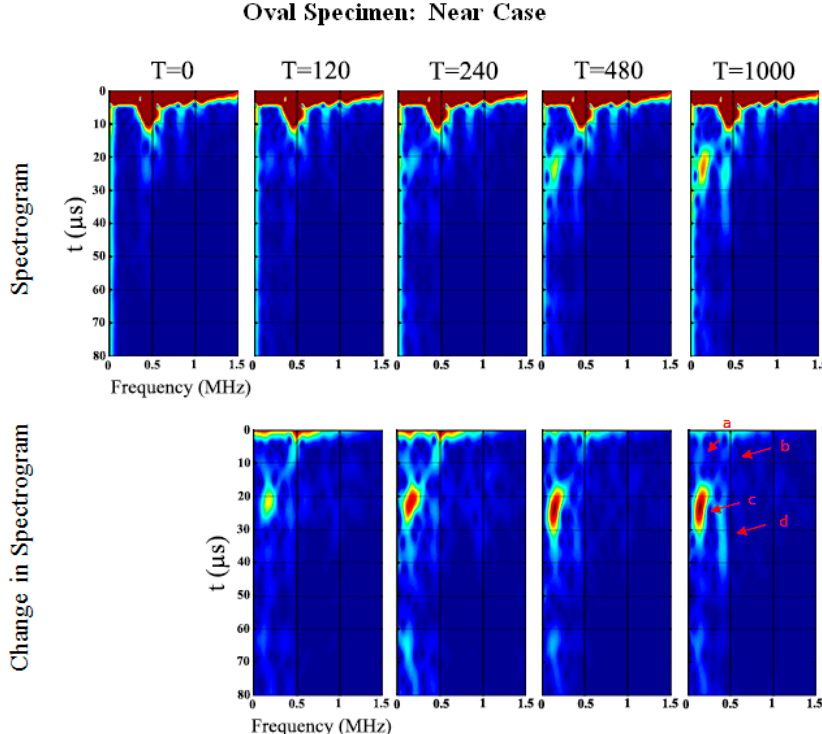
Figure 9. Oval specimen (Near): Spectrogram and changes in spectrogram for each cure time relative to the baseline.